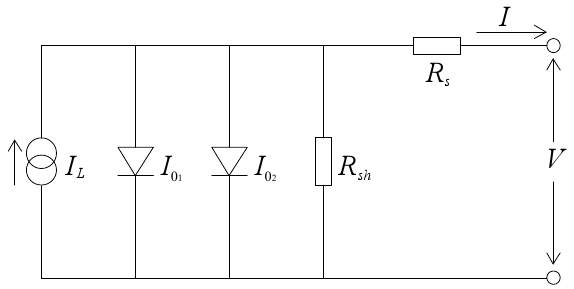
Figure 1. Two-diode equivalent circuit for a PV panel.